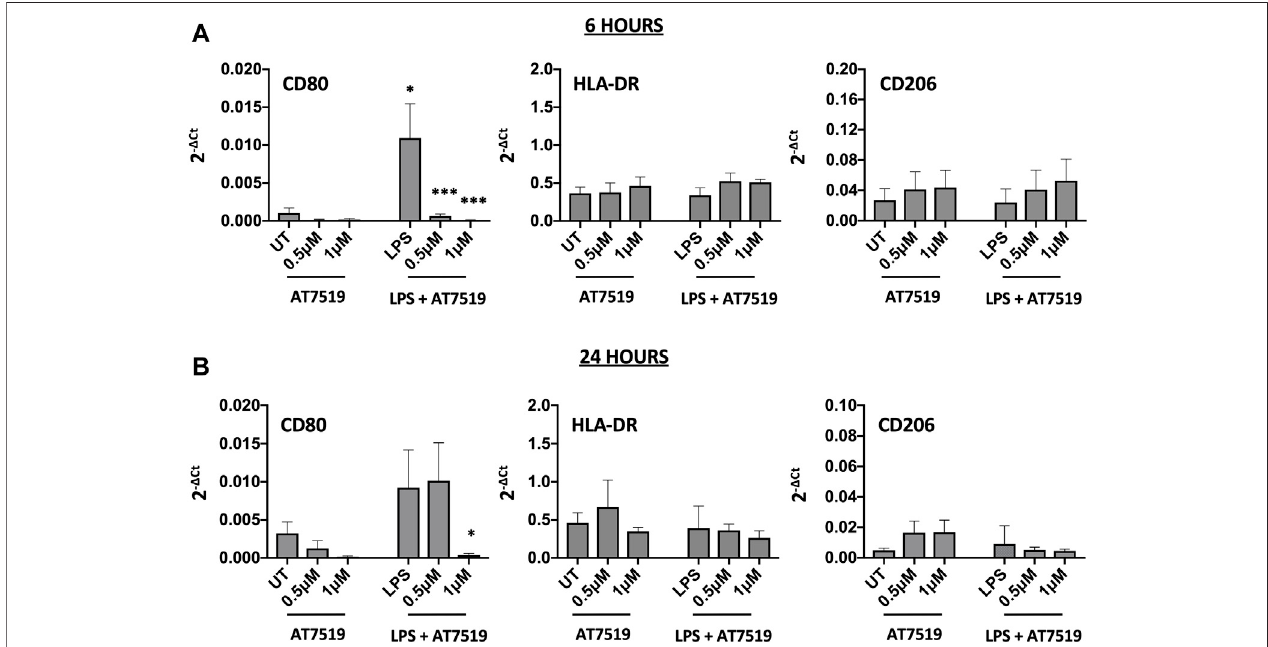
FIGURE 2 | Pharmacological inhibition of CDK9 by AT7519 alters markers of pro-in fl ammatory polarisation. CD80, HLA-DR and CD206 mRNA expression levels byMDMseitheruntreated (UT) orpre-treated withAT7519 withor withoutLPS at either6 (A) or 24 (B) hours.Datarepresentmeans±SEM from n =6separate donors, * p < 0.05 ** p < 0.01 *** p <